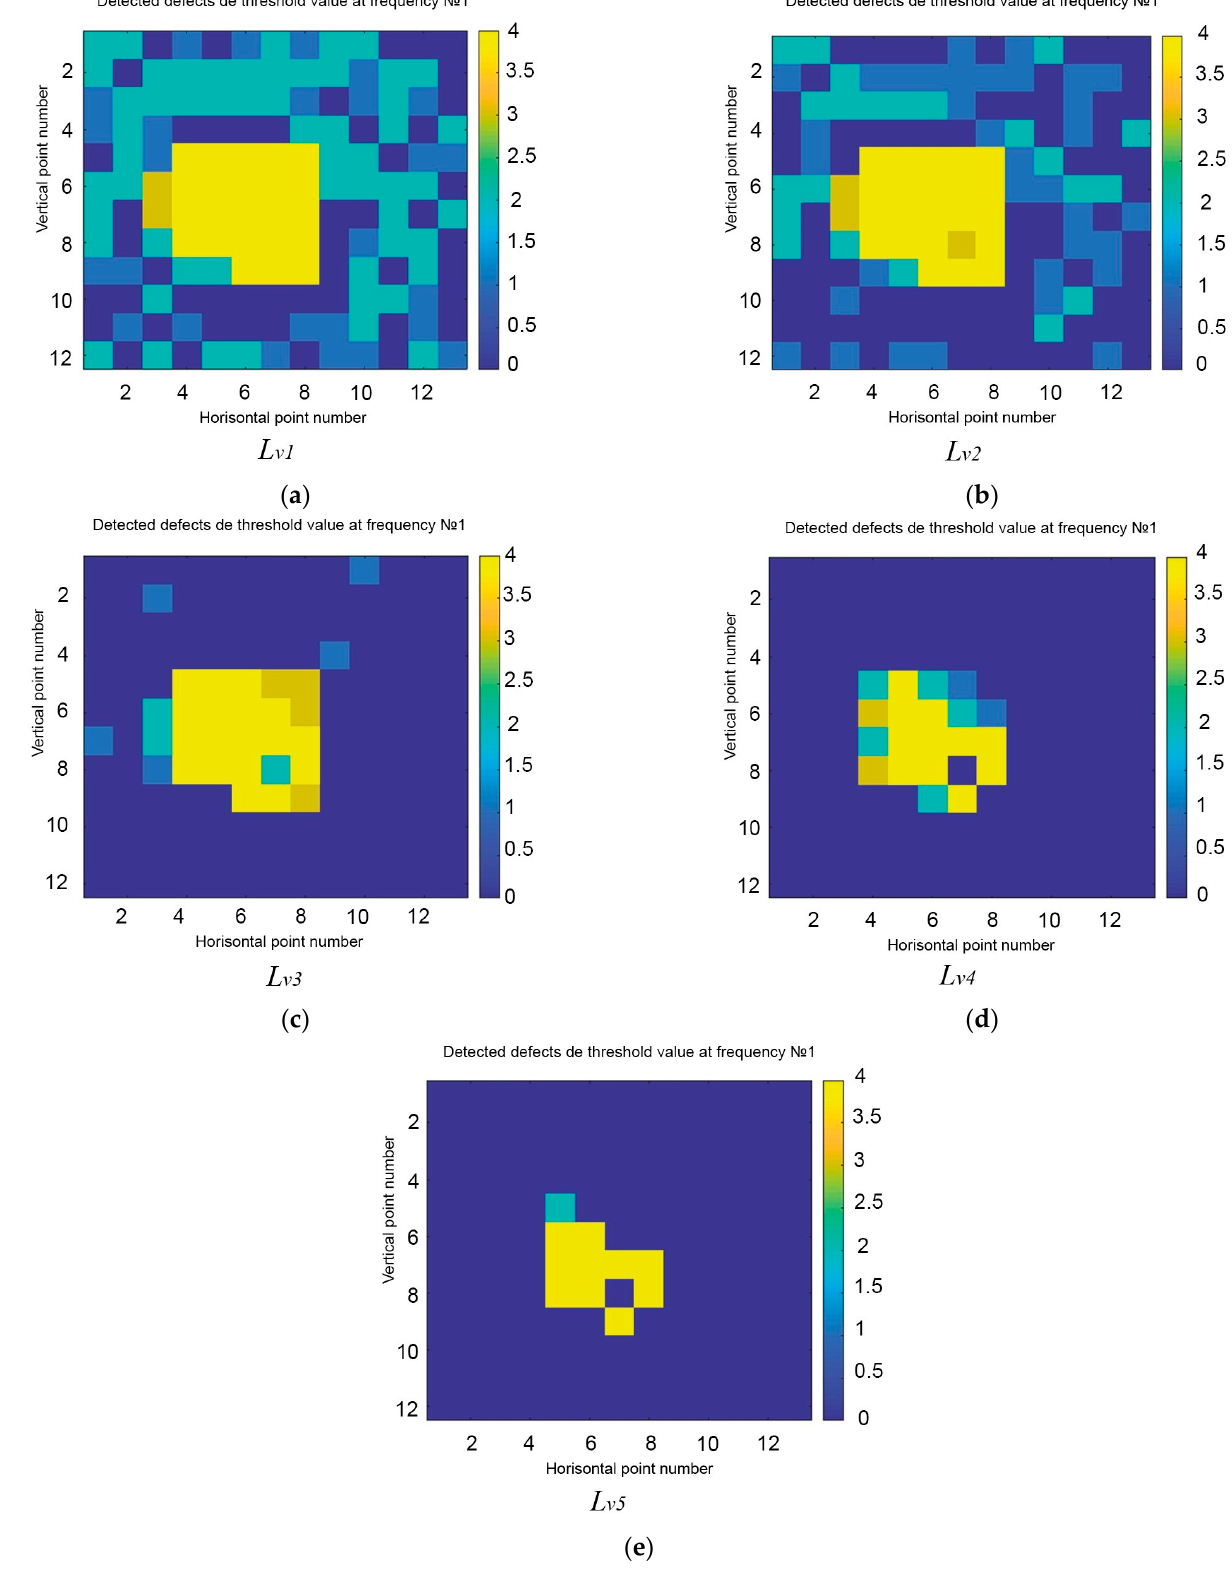
Figure 12. Schematic representation of defectiveness zones at various values L v : ( a ) L v 1 ; ( b ) L v 2 ; ( c ) L v 3 ; ( d ) L v 4 ; ( e ) L v 5 .